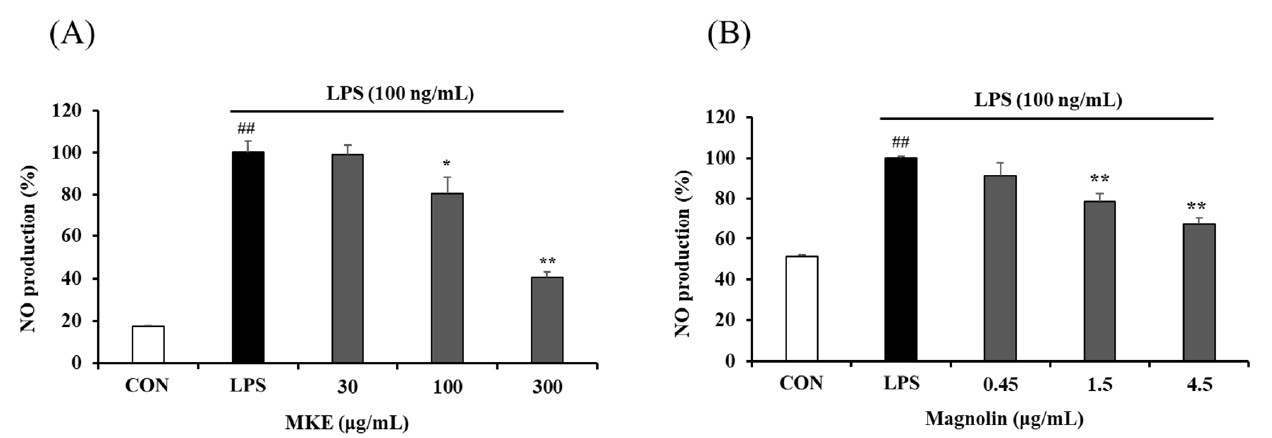
Figure 3. Effect of ( A ) MKE (30, 100, and 300 μg/mL) and ( B ) magnolin (0.45, 1.5, and 4.5 μg/mL) on RAW 264.7 cell NO production. MKE and magnolin were used for 24 h with LPS. Nitrite formed in the supernatant was measured using Griess’ reagent. Values represent means ± standard deviation. ## p < 0.01 vs. Vehicle control group; * p < 0.05 and ** p < 0.01 vs. LPS-activated control group.